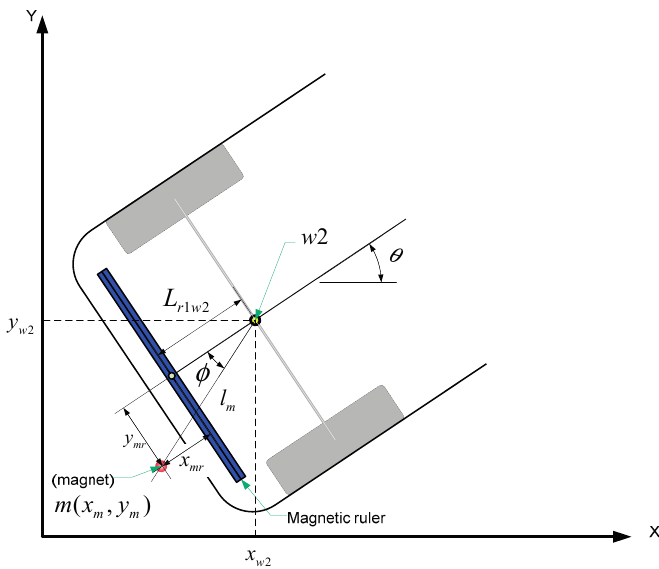
Figure 12. Schematic of measurement model with respect to the central positions of the rear axle and